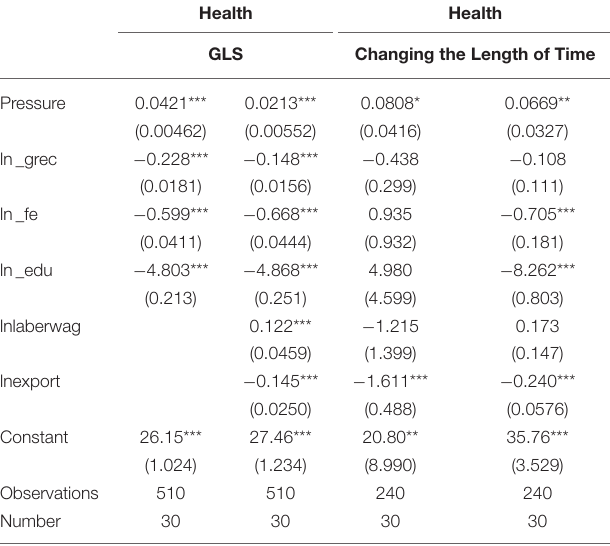
TABLE 4 | Robustness